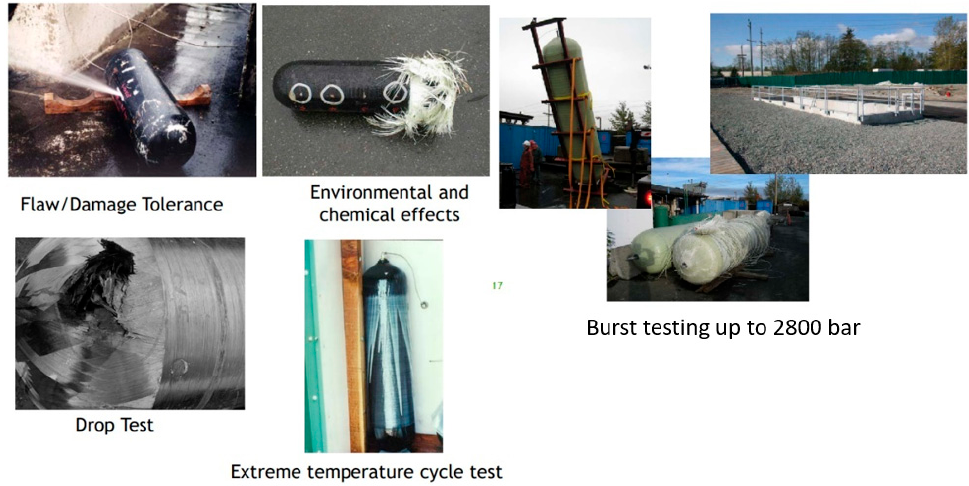
Figure 22. Hydrogen tank safety testing [105].